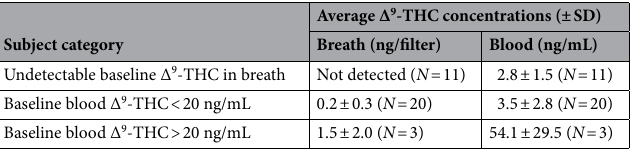
Table 3. Relationship between baseline ∆ 9 -THC concentrations in exhaled breath and blood ( N = 34).